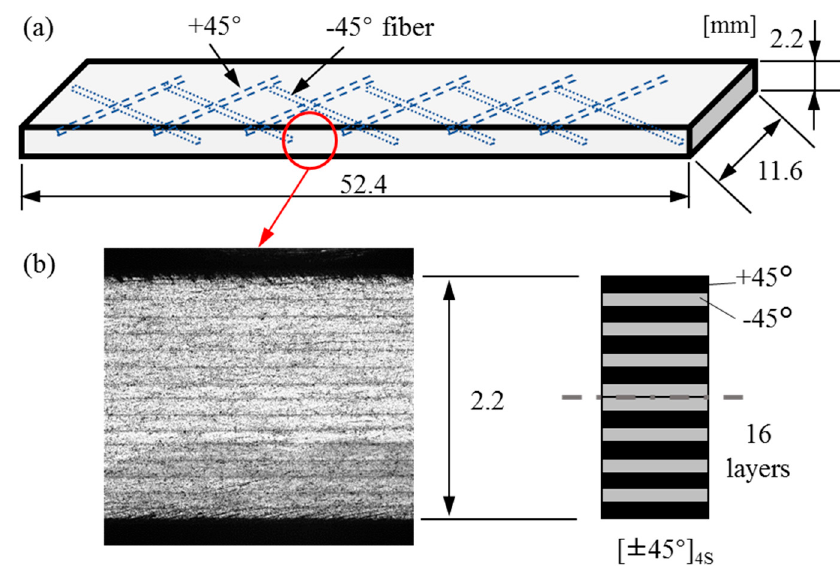
Figure 3. Carbon fiber reinforced plastic (CFRP) specimen geometry: ( a ) Specimen size and fiber directions; ( b ) surface image and layer structure on cross section.